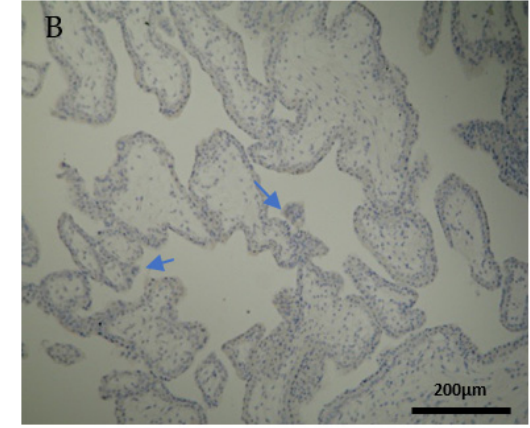
Figure 3 . Evaluation of positive CD4 antigen expression. Miscarriage Experimental Group (EG): ( A ) Moderate intensity of staining in the DB (4 × 40 magnification). ( B ) Low intensity of staining in the chorionic villi (4 × 10 magnification).